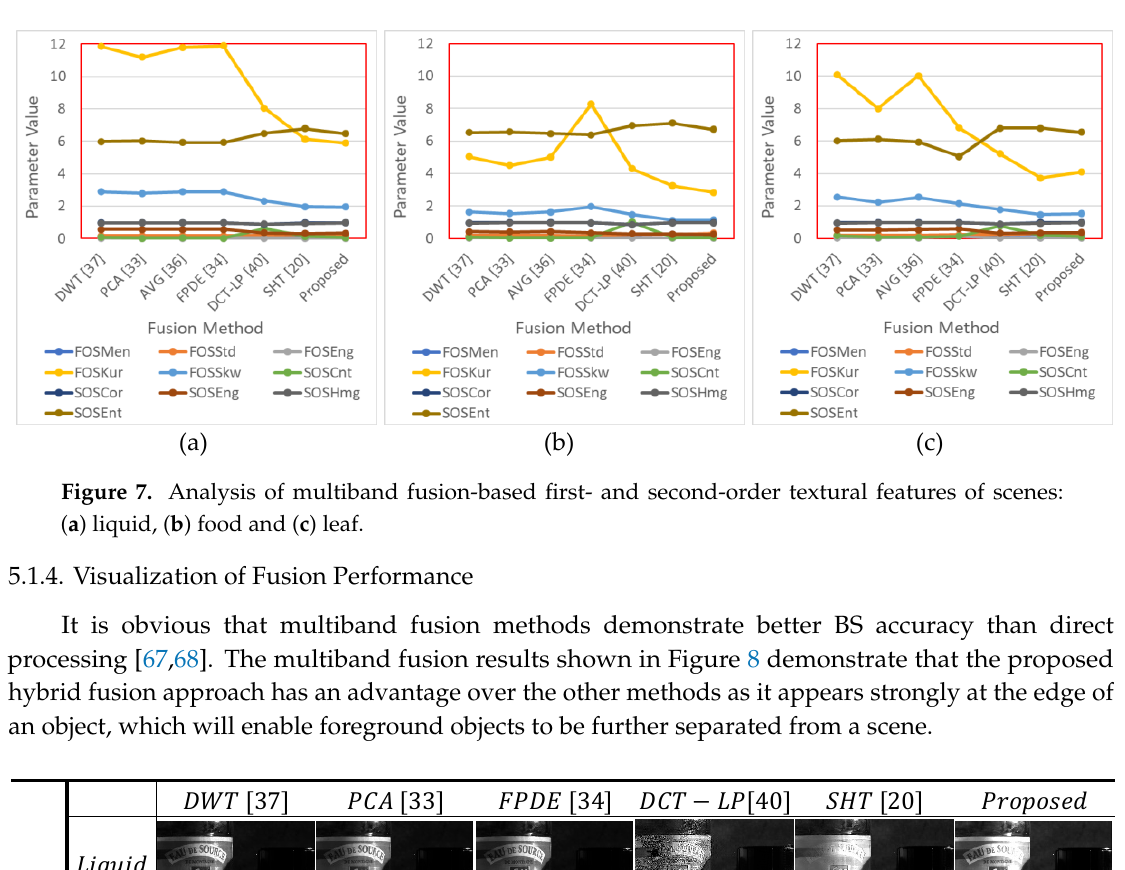
Figure 7. Analysis of multiband fusion-based first- and second-order textural features of scenes: ( a ) liquid, ( b ) food and ( c ) leaf.